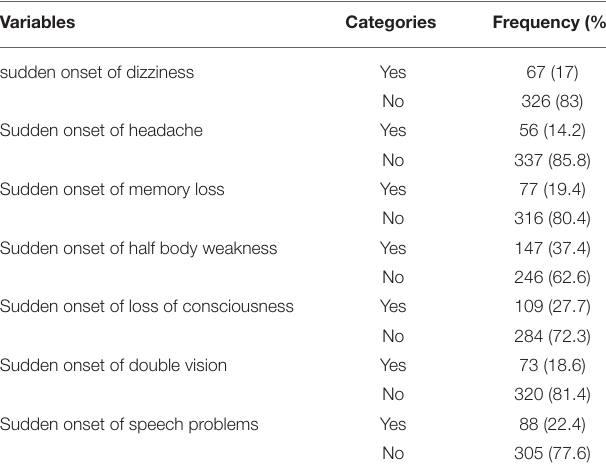
TABLE 3 | Stroke warning sign/symptom of patients attending in chronic illness follow-up Clinic of University of Gondar Comprehensive Specialized Hospital, Northwest, Ethiopia, 2021 ( n =